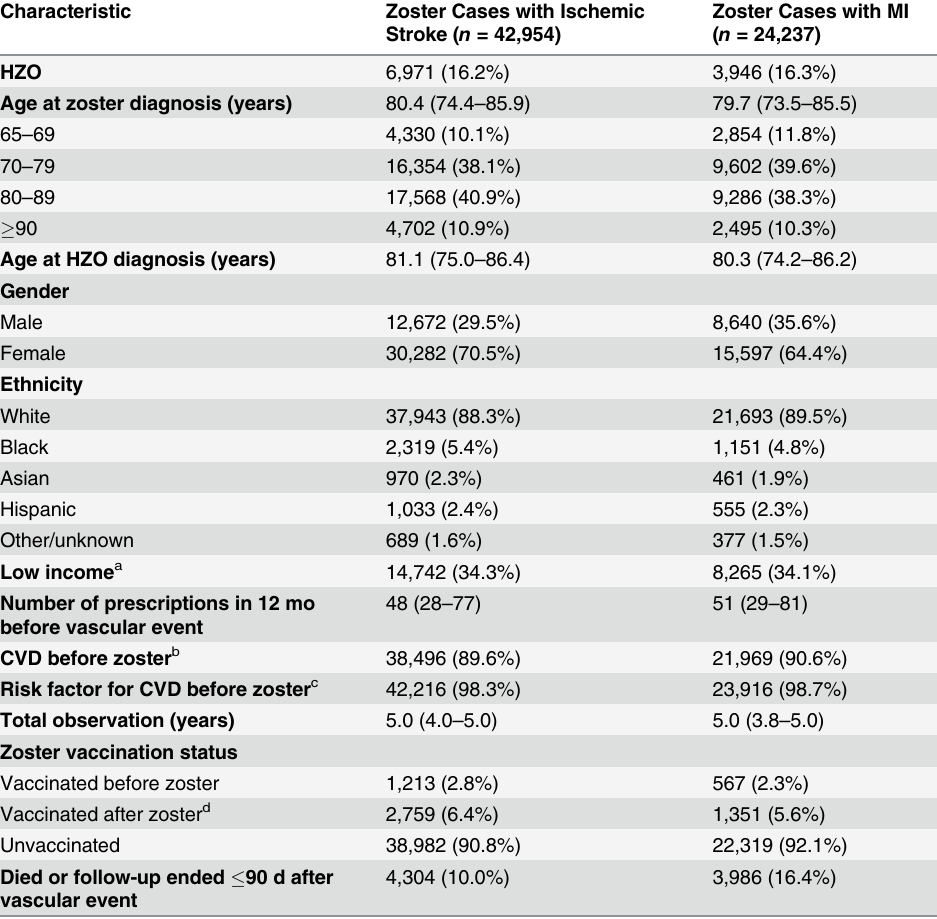
Table 1. Participant